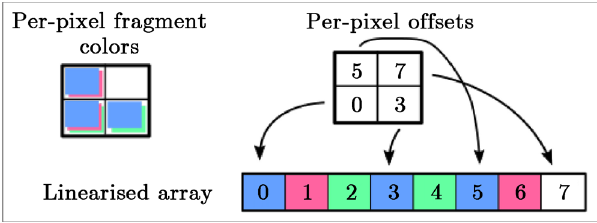
Fig. 3 Computing unique per-direction fragments in the fragment shader from object space positions.